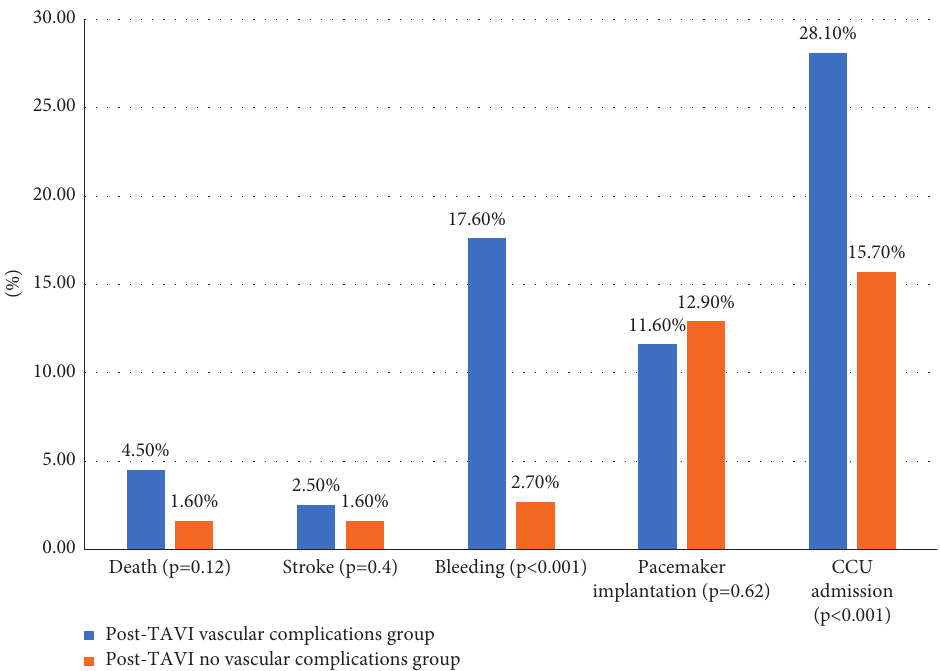
Figure 2: Univariate analysis comparing the prevalence of post-TAVI complications between the two groups. Table 4: Stepwise logistic regression studying the association between vascular complications, predictors, and adverse outcomes. Variables OR 95%